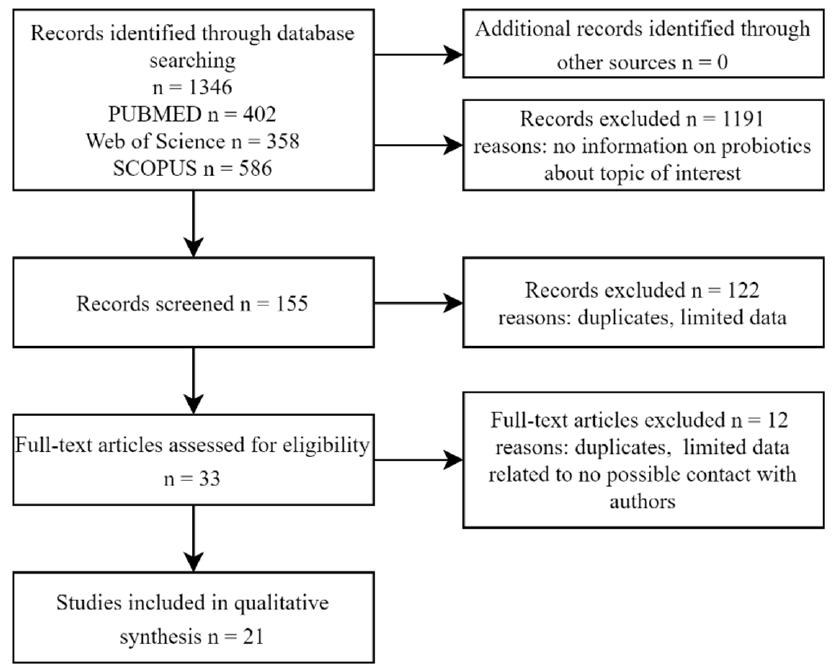
Figure 1. Flow chart of the database searches on influence of probiotics on radio- and chemotherapy side effects.